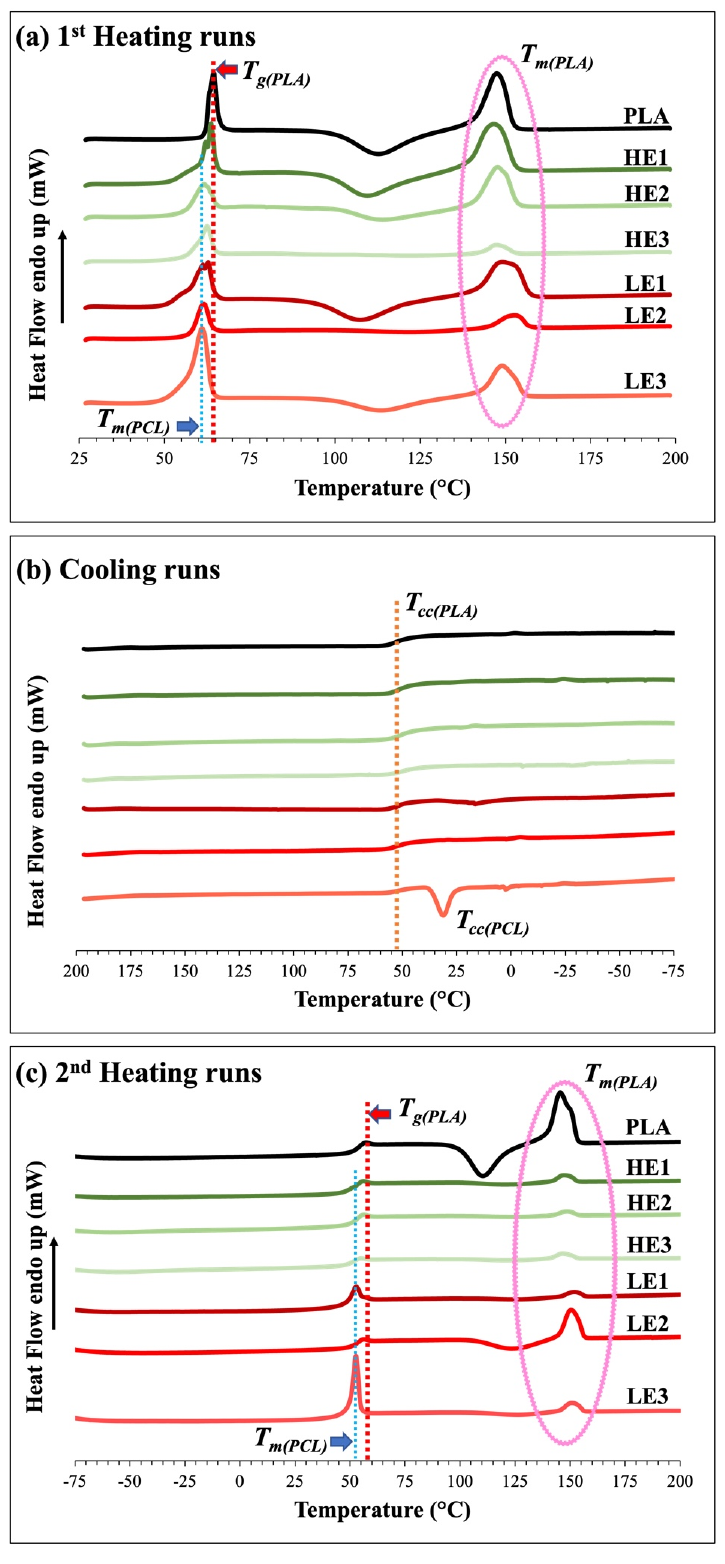
Figure 5. DSC thermograms of ternary-blended, melt-blown films of PLA/PCL/CAB; ( a ) first heating runs, ( b ) cooling runs and ( c ) second heating run.